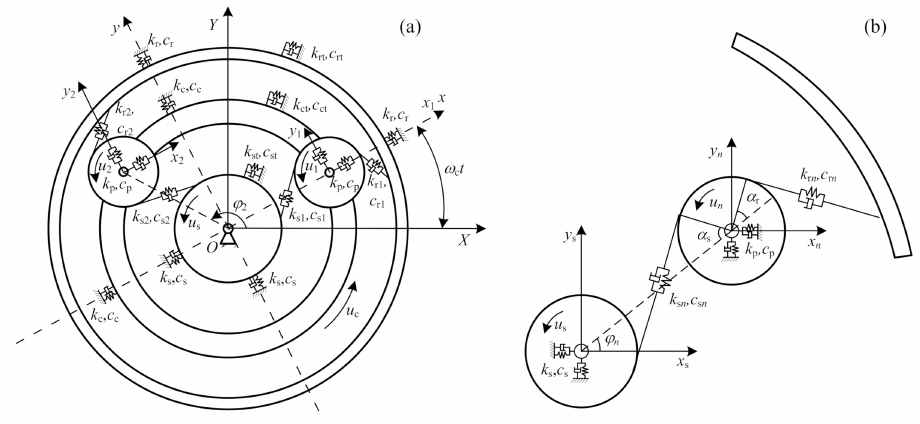
Figure 4. Planetary gearbox: ( a ) dynamic model and ( b ) relative